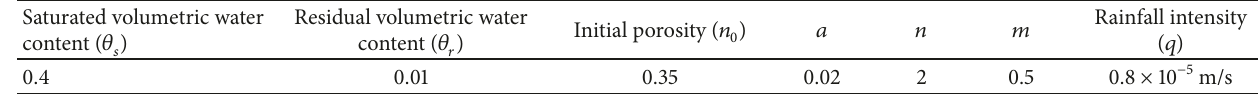
Table 2: The parameters used in the calculations involving SWCC.